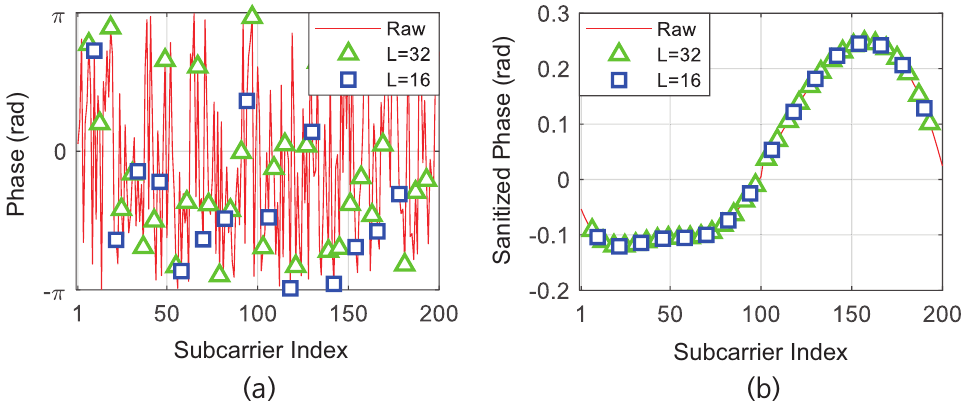
Figure 6. Raw and irregularly sampled channel phase profiles of ( a ) independently simulated and ( b ) USRP experimented correlated